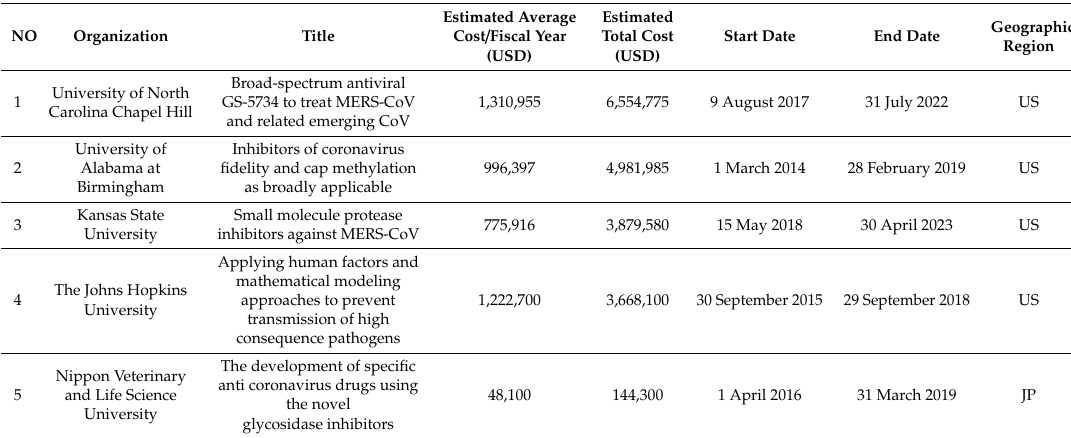
Table 6. Studies on the design of antiviral agents based on the structure and function of viral and human receptor proteins (Sub-Cluster 2-2).